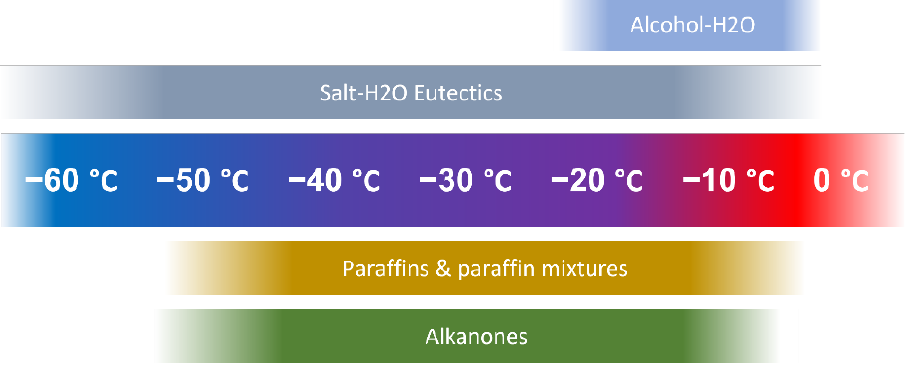
Figure 6. Usable temperature ranges for some of the most relevant PCM types for negative Celsius temperatures [45,47 – 49,51,53].